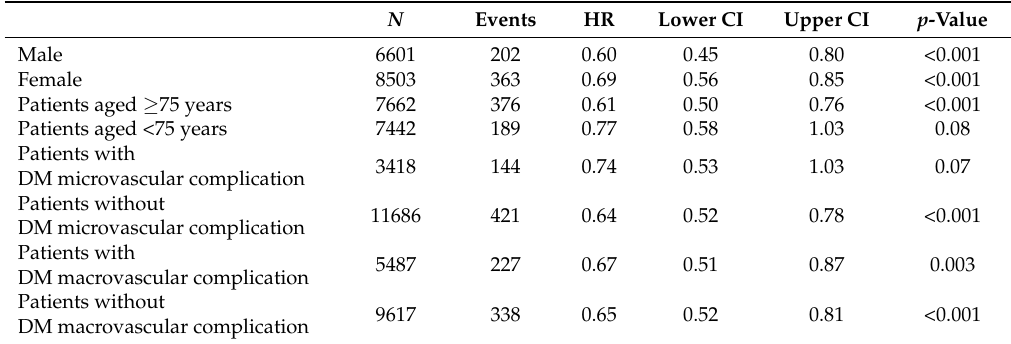
Table 3. Subgroup analyses according to sex, age, and presence of diabetic microvascular or macrovascular